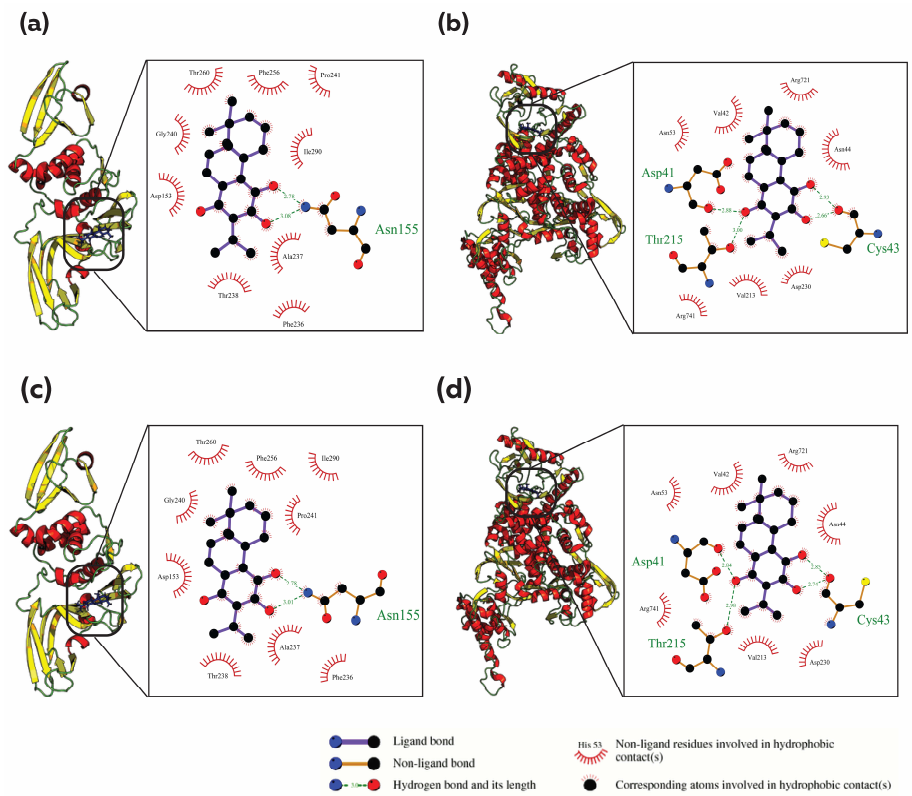
Figure 3. Analysis of protein–ligand interaction for Royleanone (PubChem CID: 442084) and 6,7- Dehydroroyleanone (PubChem CID: 2751794) against PLpro and RdRp; Analysis of the binding pocket and types of interaction between ( a ) 442084 and PLpro, ( b ) 2751794 and RdRp, ( c ) 2751794